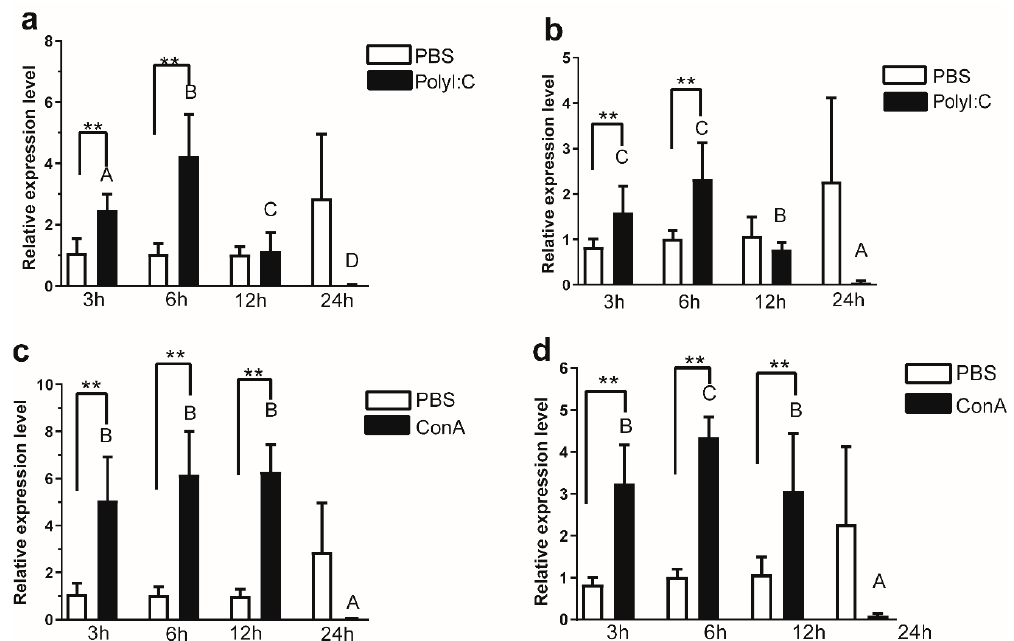
Figure 5. Transcript levels of psIL6 and psIL6ns in primary spleen cells upon stimulation. The relative expression method was used in the calculation with ef1 α as the reference gene. In the X -axis, stimulation times (h) are listed. ( a ) psIL6 and ( b ) psIL6ns expression after poly I: C (5 µ g mL − 1 ) stimulation, ( c ) psIL6 and ( d ) psIL6ns expression after ConA (25 µ g mL − 1 ) stimulation. The data are presented as mean + SD ( n = 6). Different letters above the bars represent statistical significance between the time-points ( p < 0.05); ** p < 0.01; *** p < 0.001. Two-way ANOVA analysis was carried